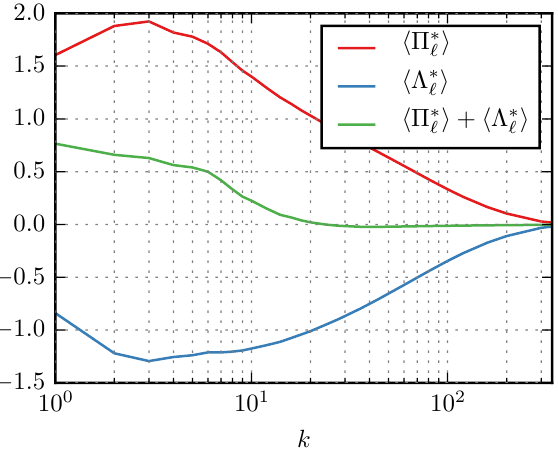
Figure 4. Flux terms Π (cid:96) and Λ (cid:96) from Run 1, as well as their sum averaged over space and time, as a function of the filtering wavenumber k = 2 π / (cid:96) . Filtering here uses the sharp-spectral filter kernel. The star superscript indicates normalization by the effective kinetic energy injection, p ∇· u ε ef f = ε inj + . (cid:104) (cid:105)